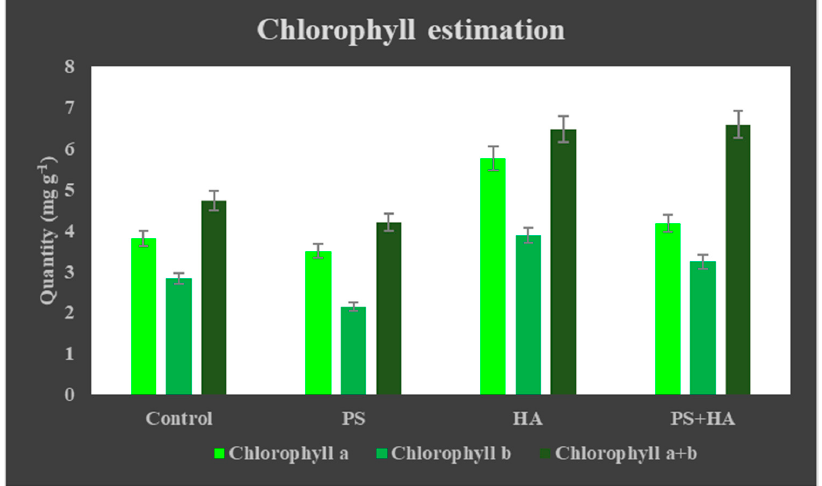
Figure 9. Effects of Control, PS, HA, PS + HA on Solanum lycopersicum chlorophyll estimation.